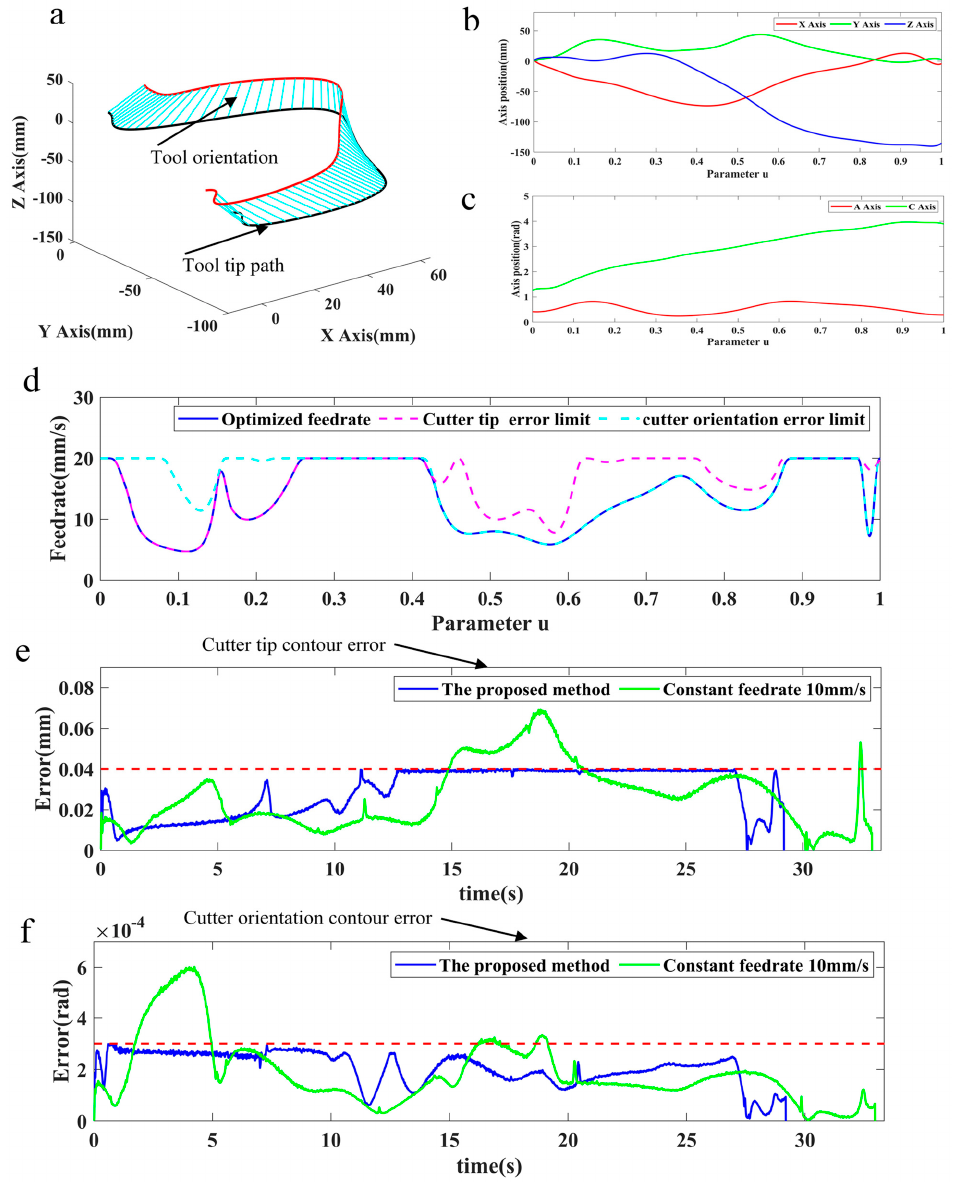
Figure 9. Comparative experimental results of five-axis flank milling: ( a ) toolpath is expressed by dual NUBRS; ( b ) position curve of linear axes; ( c ) position curve of rotary axes; ( d ) feedrate curve considering the contour error of cu tt er tip and cu tt er orientation constraint; ( e ) comparative experimental results of cu tt er tip contour accuracy; ( f ) comparative experimental results of cu tt er orientation contour accuracy.